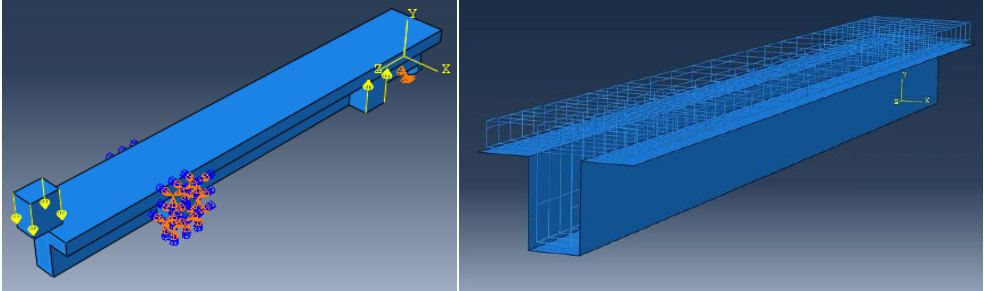
Figure 1. T-shaped beam, CFRP, and steel bars modeling in ABAQUS.